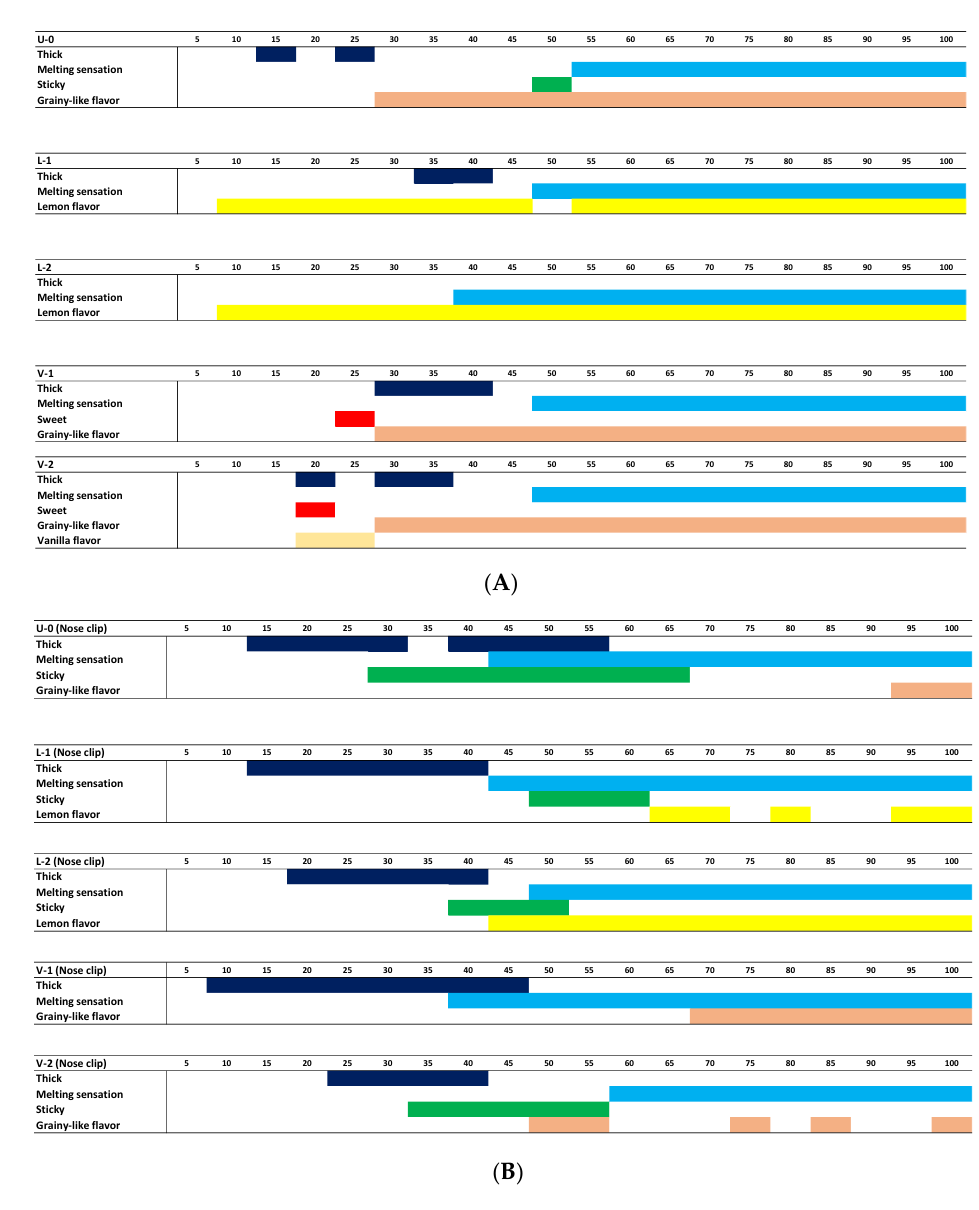
Figure 2. Dominant sensory properties during eating on a standardized time scale (0 – 100) evaluated without a nose clip ( A ) and with a nose clip ( B ) ( n = 4 × 20).